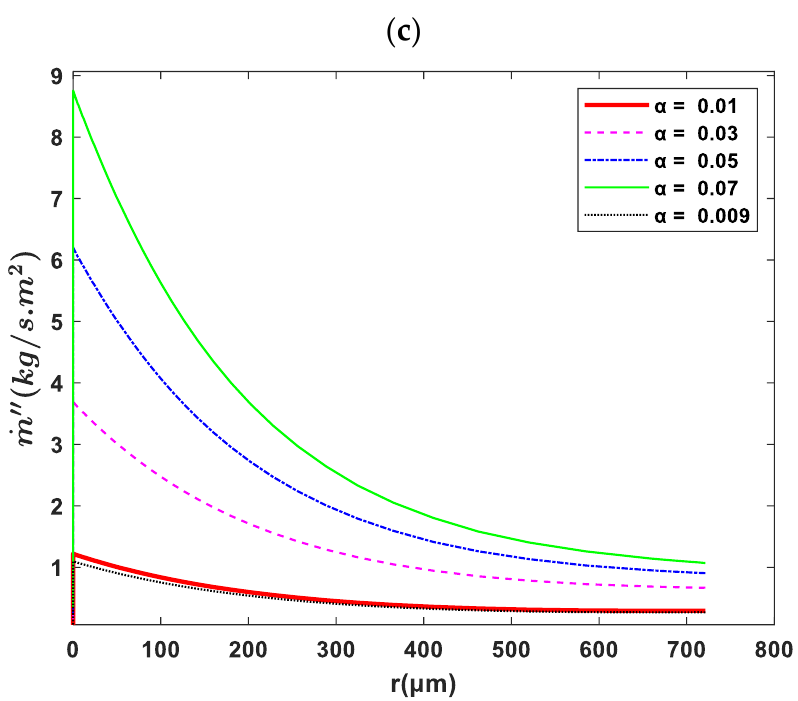
Figure 11. Radius evolutions of ( a ) film thickness; ( b ) interfacial temperature; and ( c ) evaporative mass flux for different accommodation coefficients at a time step of 3.9 ms.